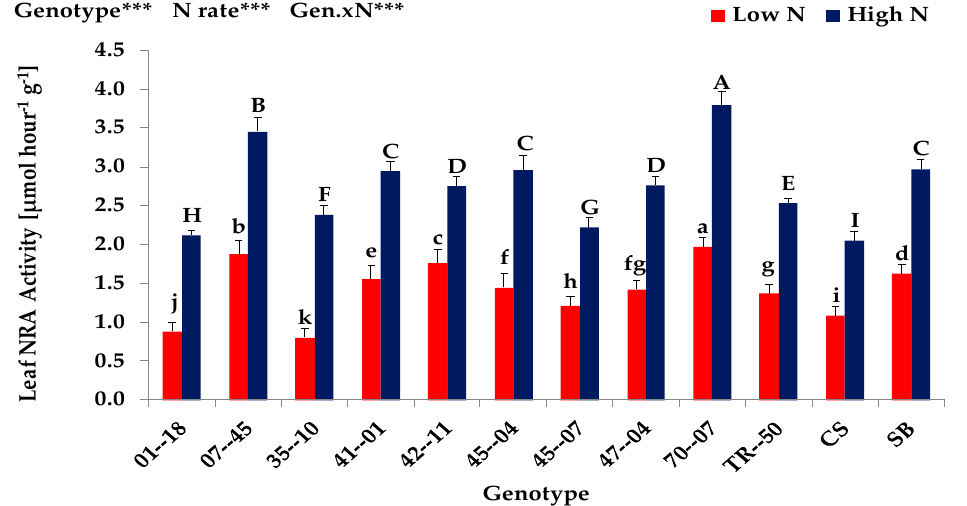
Figure 2. Leaf NRA activity of the ten bottle gourd genotypes and two watermelon cultivars grown under low (0.3 mM) and high (3.0 mM) N supply in Expt. 1 . Values denoted by different letters (lower- and upper-case letters for low and high N supply, respectively) are significantly different between genotypes within columns at p < 0.05. ns, non-significant. * p < 0.05, ** p < 0.01 and *** p < 0.001.